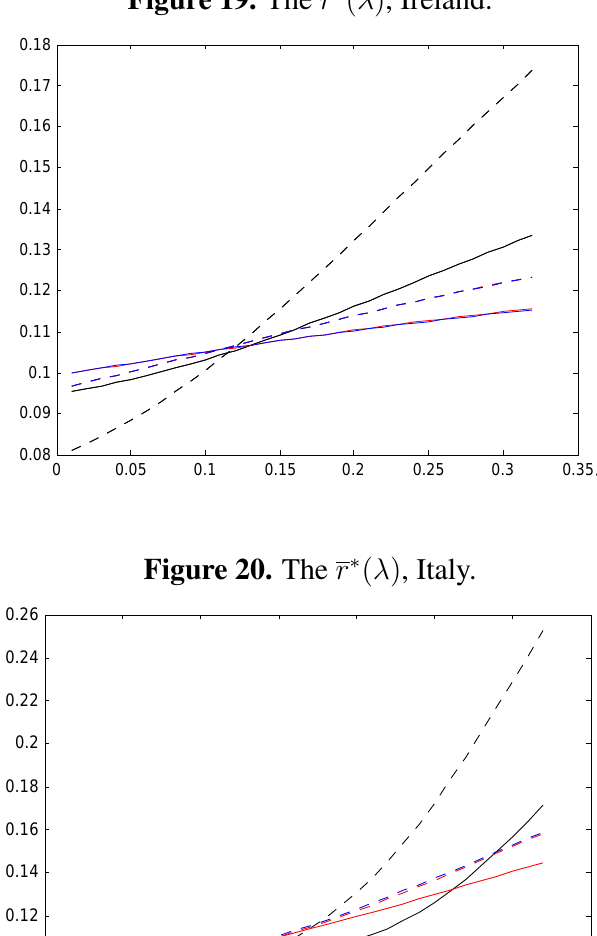
Figure 19. The r ∗ ( λ ) , Ireland.